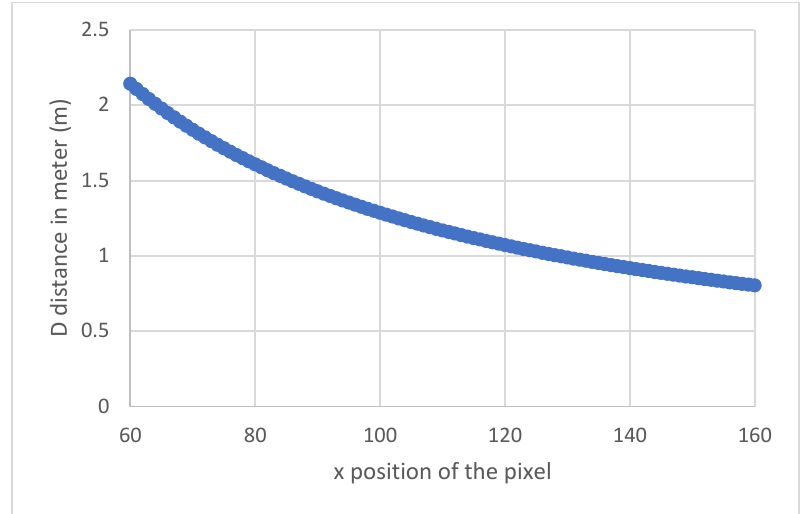
Figure 3. Presentation of the setup.